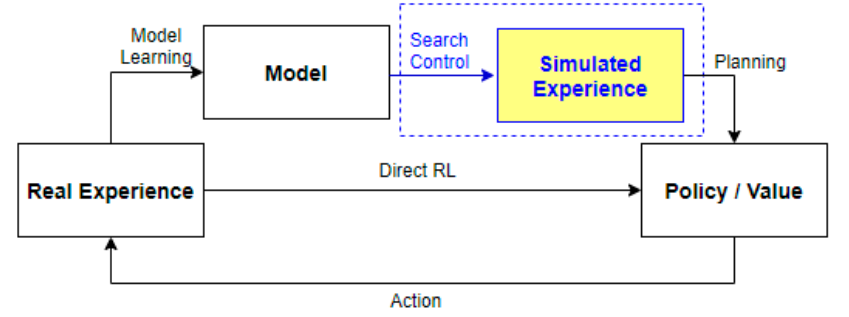
Figure 5. Dyna-Q model structure [18].